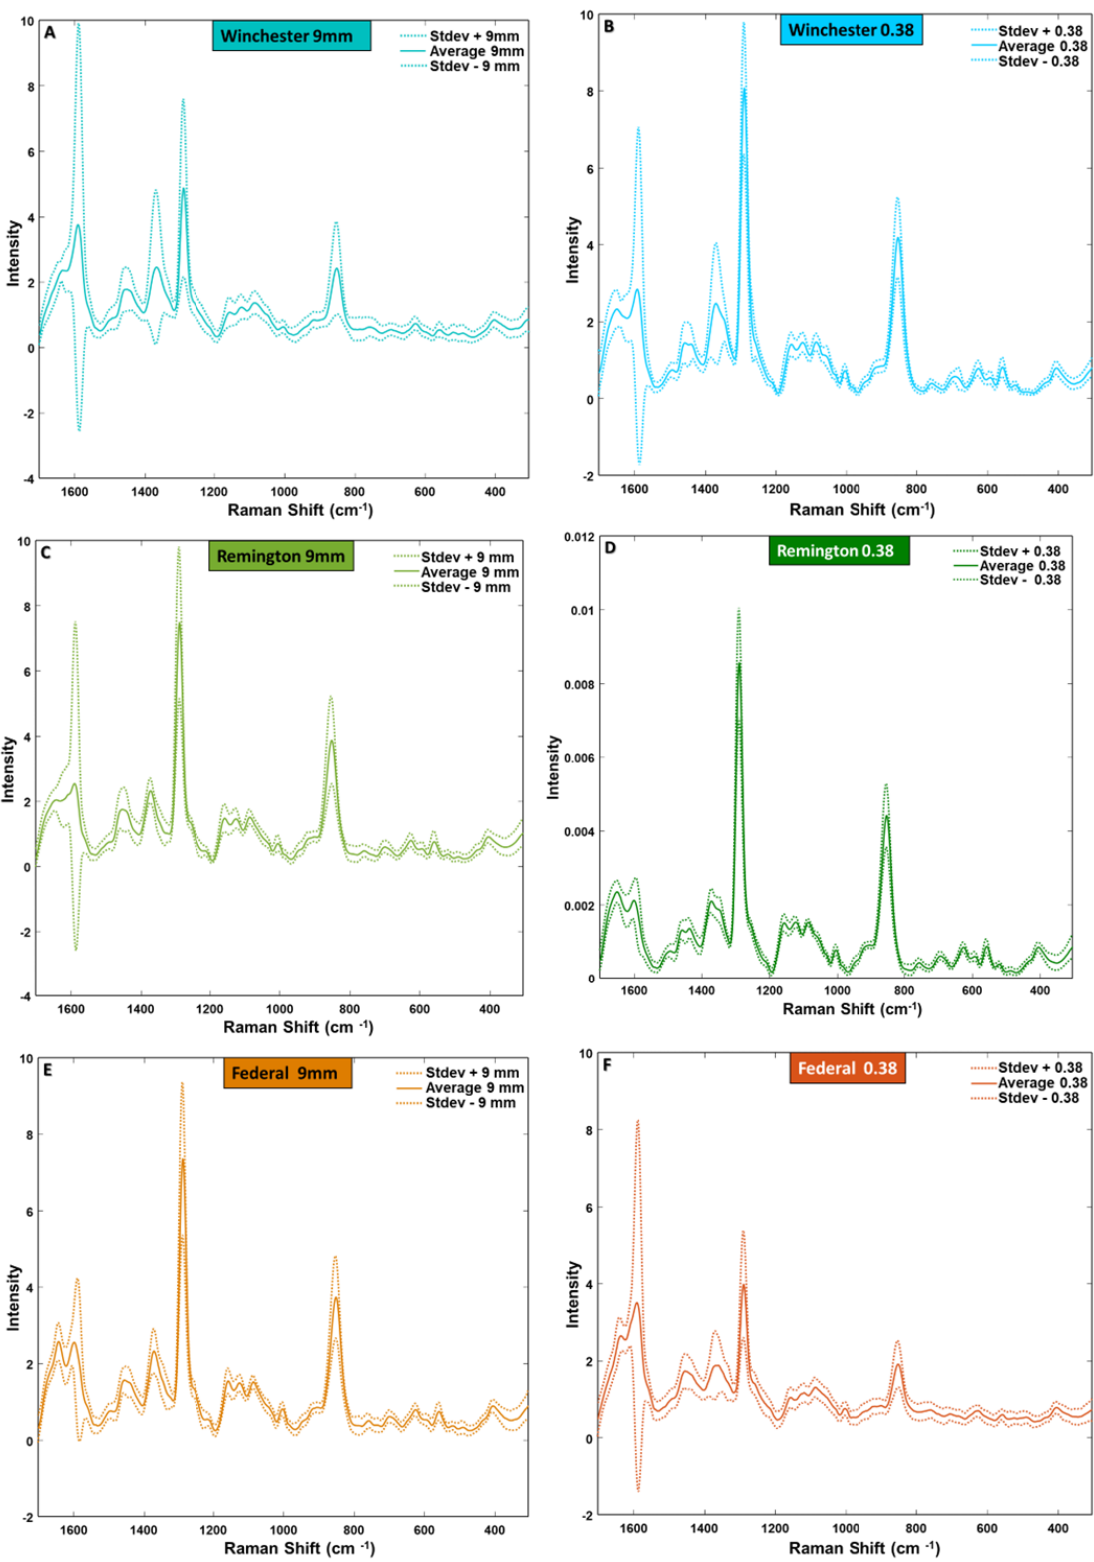
Figure 4. Average Raman spectra for each caliber shown by manufacturer and their standard spectral deviations. Labels indicate: ( A ) Winchester 9 mm, ( B ) Winchester 0.38, ( C ) Remington 9 mm, ( D ) Remington 0.38, ( E ) Federal 9 mm, and ( F ) Federal 0.38.